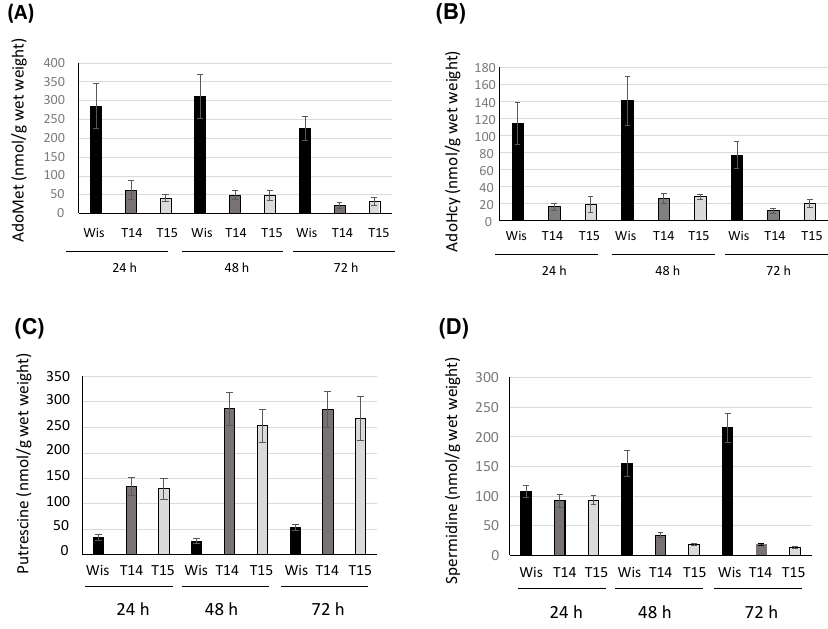
Figure 4. Specific production (nmol/g wet weight) of ( A ) AdoMet, ( B ) AdoHcy, ( C ) putrescine and ( D ) spermidine in the knock-down transformants T14 and T15 and the control strain P. chrysogenum Wisconsin 54-1255 (Wis). Results correspond to the mean ± SD from three different experiments carried out in duplicate.